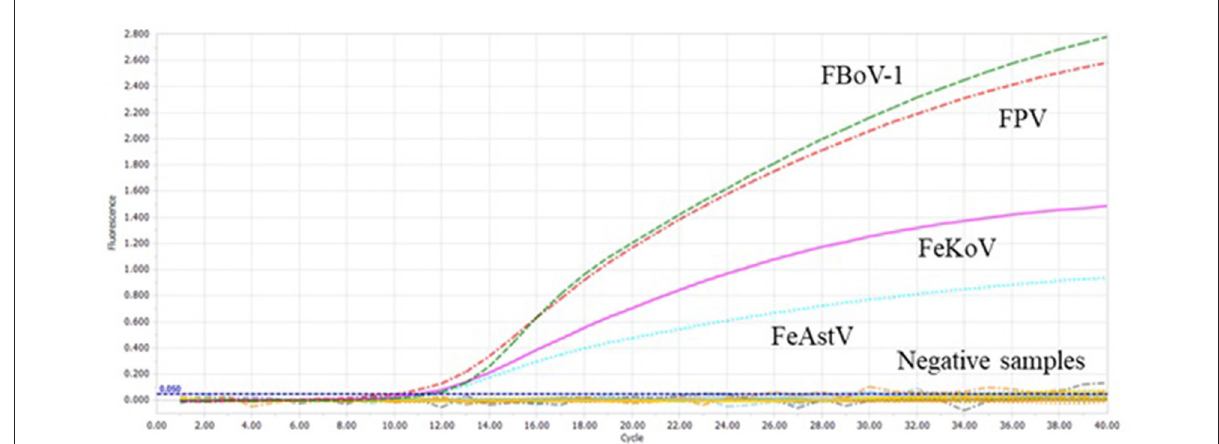
FIGURE3 The specificity of the multiplex qPCR. Feline bocavirus 1 (FBoV-1), feline parvovirus (FPV), feline kobuvirus (FeKoV), and feline astrovirus (FeAstV) showed specific amplification curves in the multiplex qPCR assay. Other samples include feline bocavirus 2 (FBoV-2), FBoV-3, feline coronavirus (FCoV), feline chaphamaparvovirus (FeChPV), and nuclease-free water.